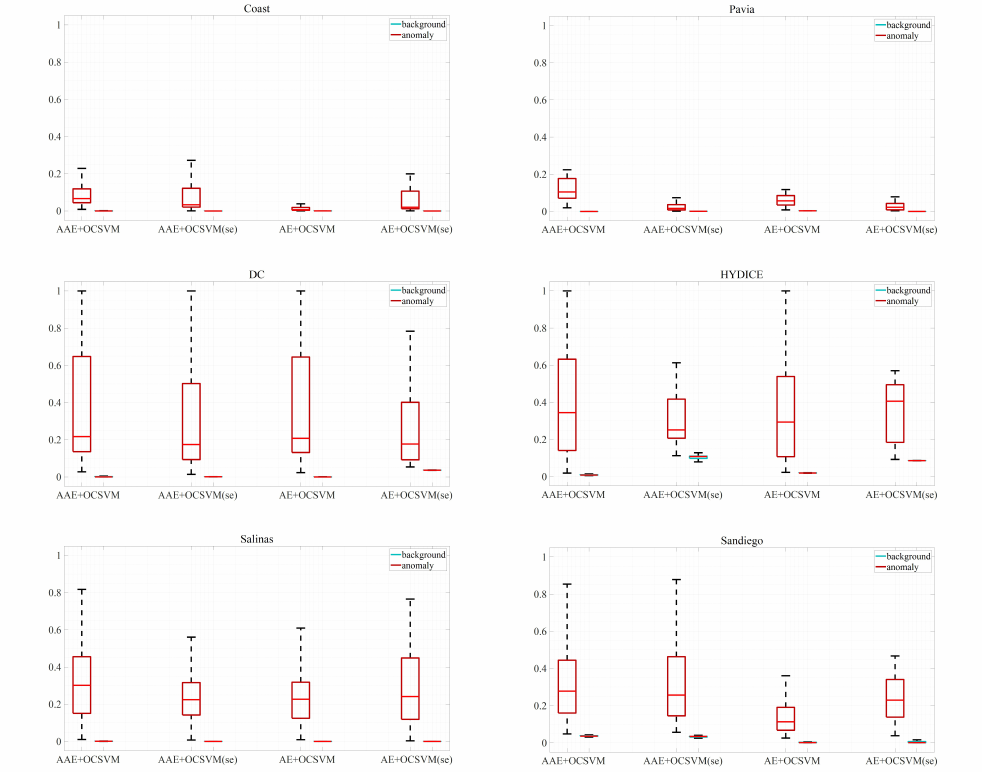
Figure 14. Box plot of training